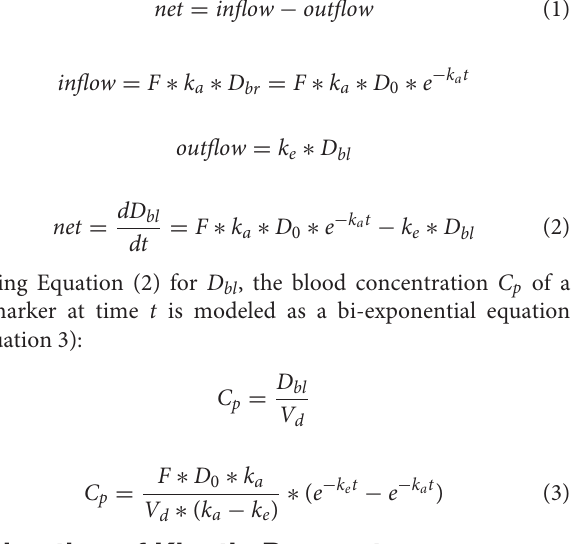
FIGURE 3 | Kinetic profiles for five blood biomarkers with parameter values for k